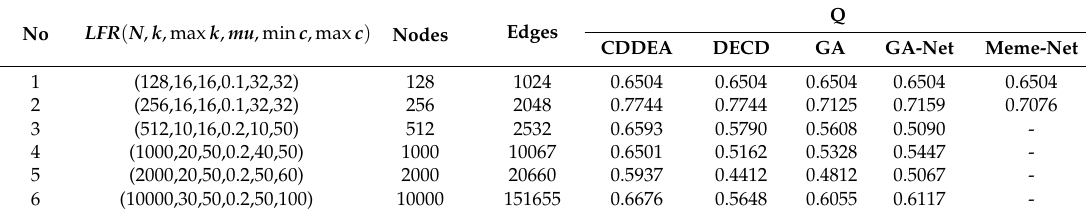
Table 9. Q value comparison of different algorithms on LFR